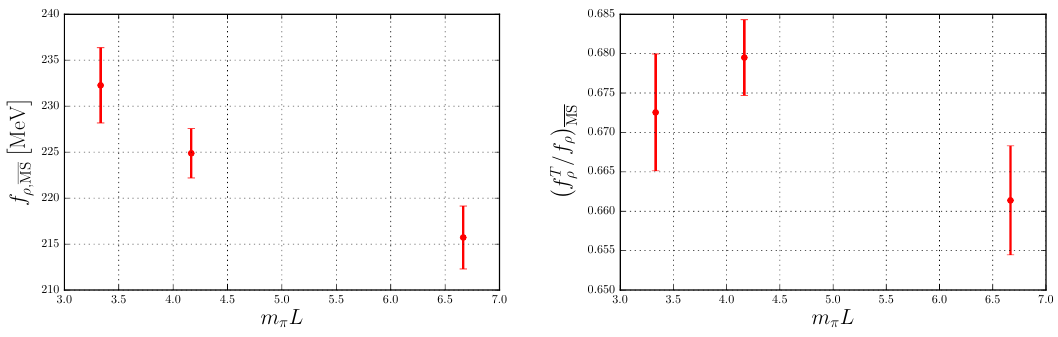
Figure 4 . Volume dependence of f